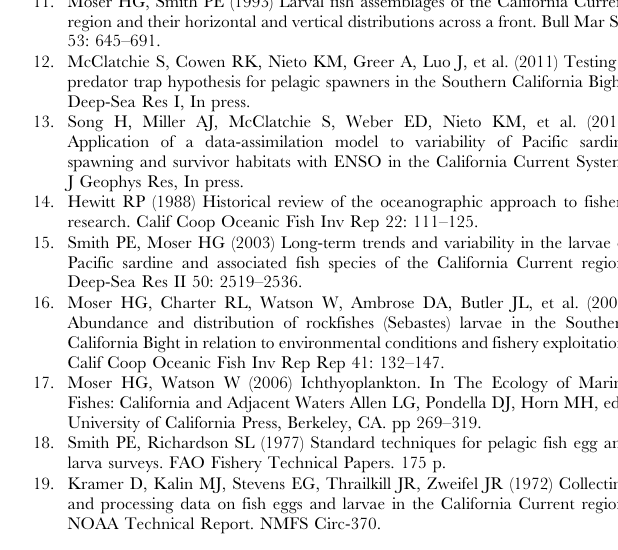
Figure S3 Hellinger-transformed values of coastal- oceanic species in the CCA from 2002–2004. (A–C) Lipolagus